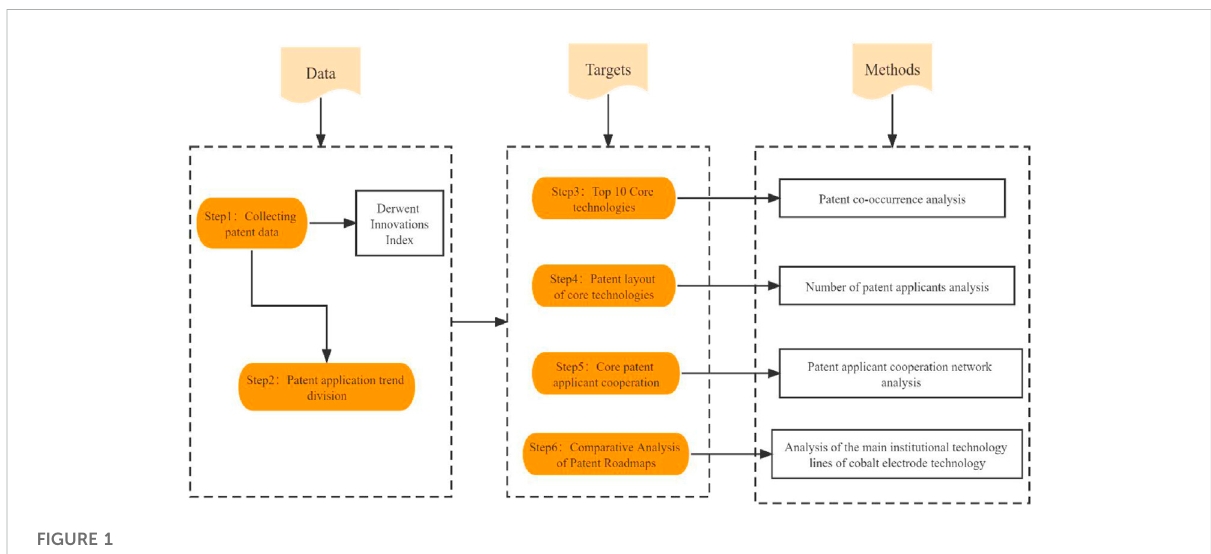
FIGURE 1 Research